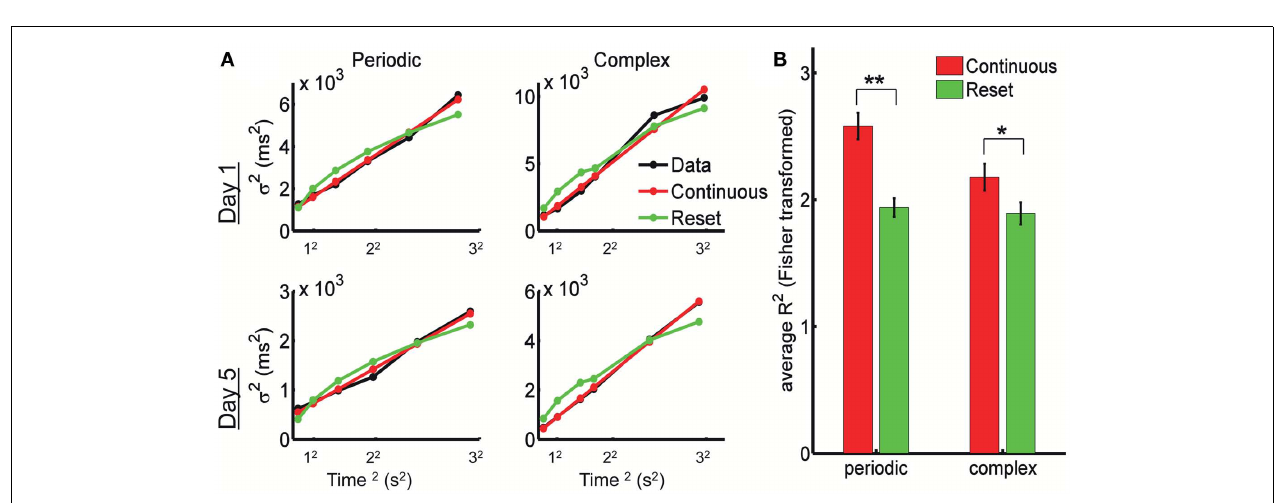
predicted variance at every point in the sequence is different, since in Reset timing the variance at each new response adds to the previous variance, whereas in Continuous timing the variance is a function of absolute time squared (note that T 3 = t 1 + t 2 + t 3 ).